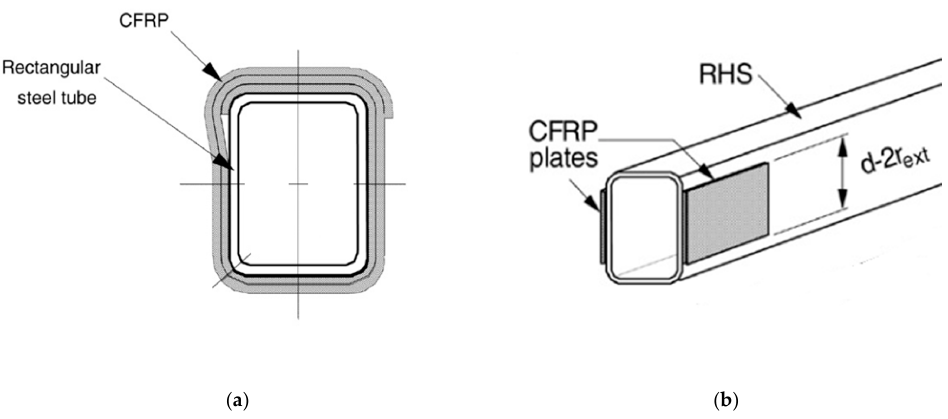
Figure 5. Strengthening with Fiber Reinforced Polymers (FRP) ( a ) sheets or ( b ) plates [13]. Abbreviation: Carbon FRPs-CFRP. Carbon